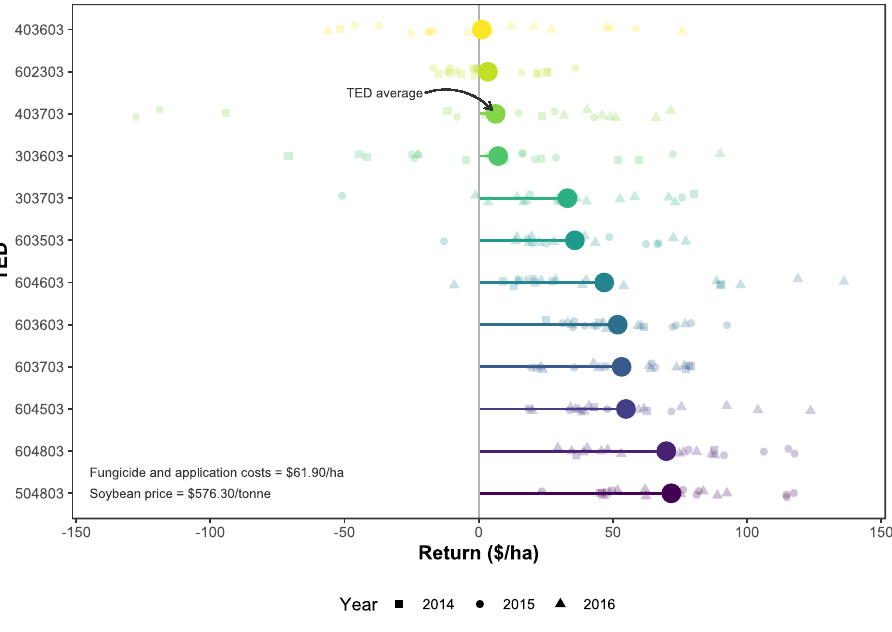
Figure 6. Partial economic analysis on the 20 highest-yielding, foliar fungicide-treated fields in the 12 technology extrapolation domains (TEDs) with the most fields. Return is the value of the yield increase attributed to foliar fungicides minus the cost of chemical and application. Soybean price fixed at US$576.30 per tonne (as of Jan 31 2021). Chemical and application costs fixed at US$61.90/ha. Individual fields are represented by the smaller symbols. The larger symbols are the mean returns for each